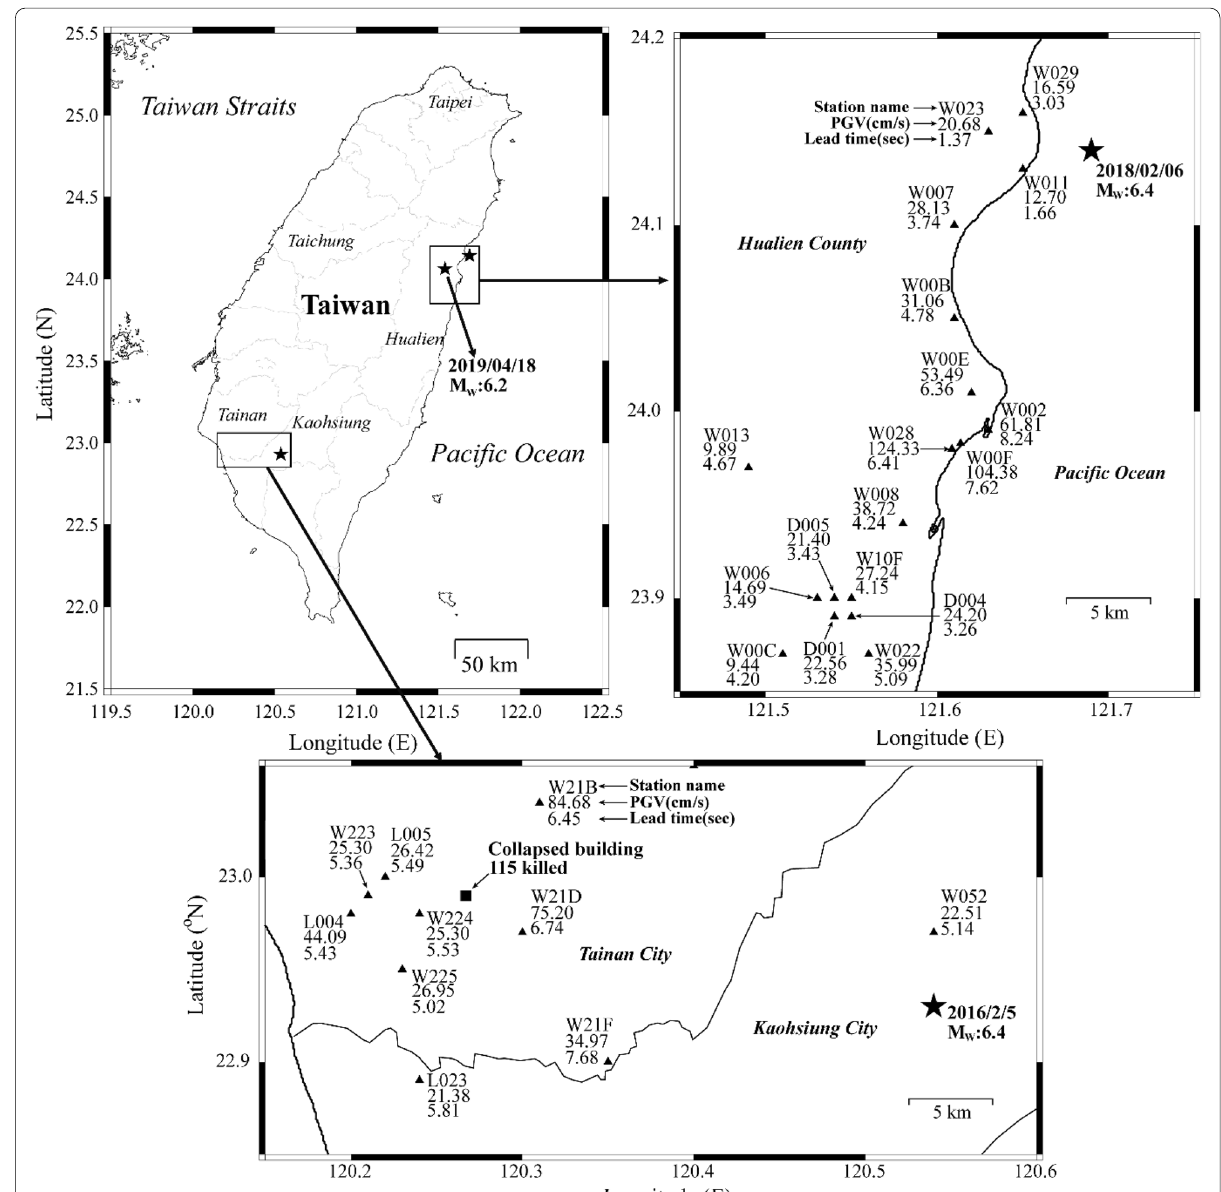
Fig. 6 Onsite warning lead time of the 2016 Meinong earthquake and the 2018 Hualien earthquake. The lead time counts from the warning time to PGV are